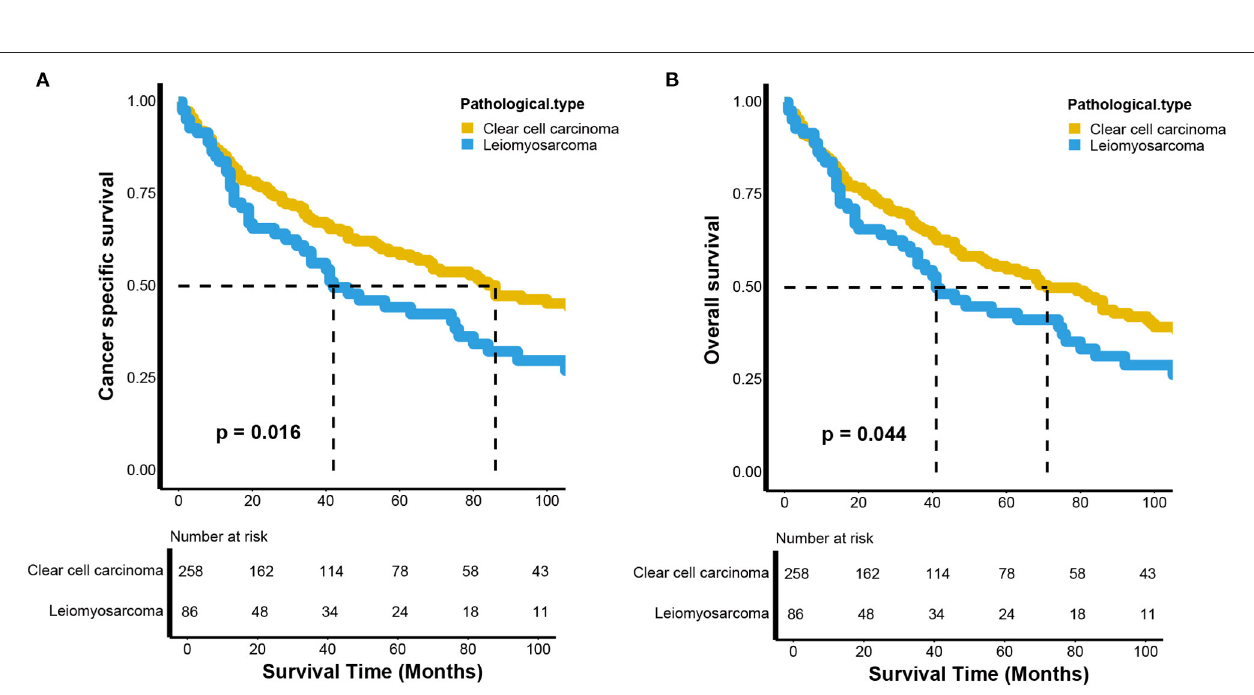
FIGURE 2 | Kaplan–Meier estimates of the (A) cancer-specific and (B) overall survival between renal leiomyosarcoma and renal clear cell carcinoma after propensity score matching.